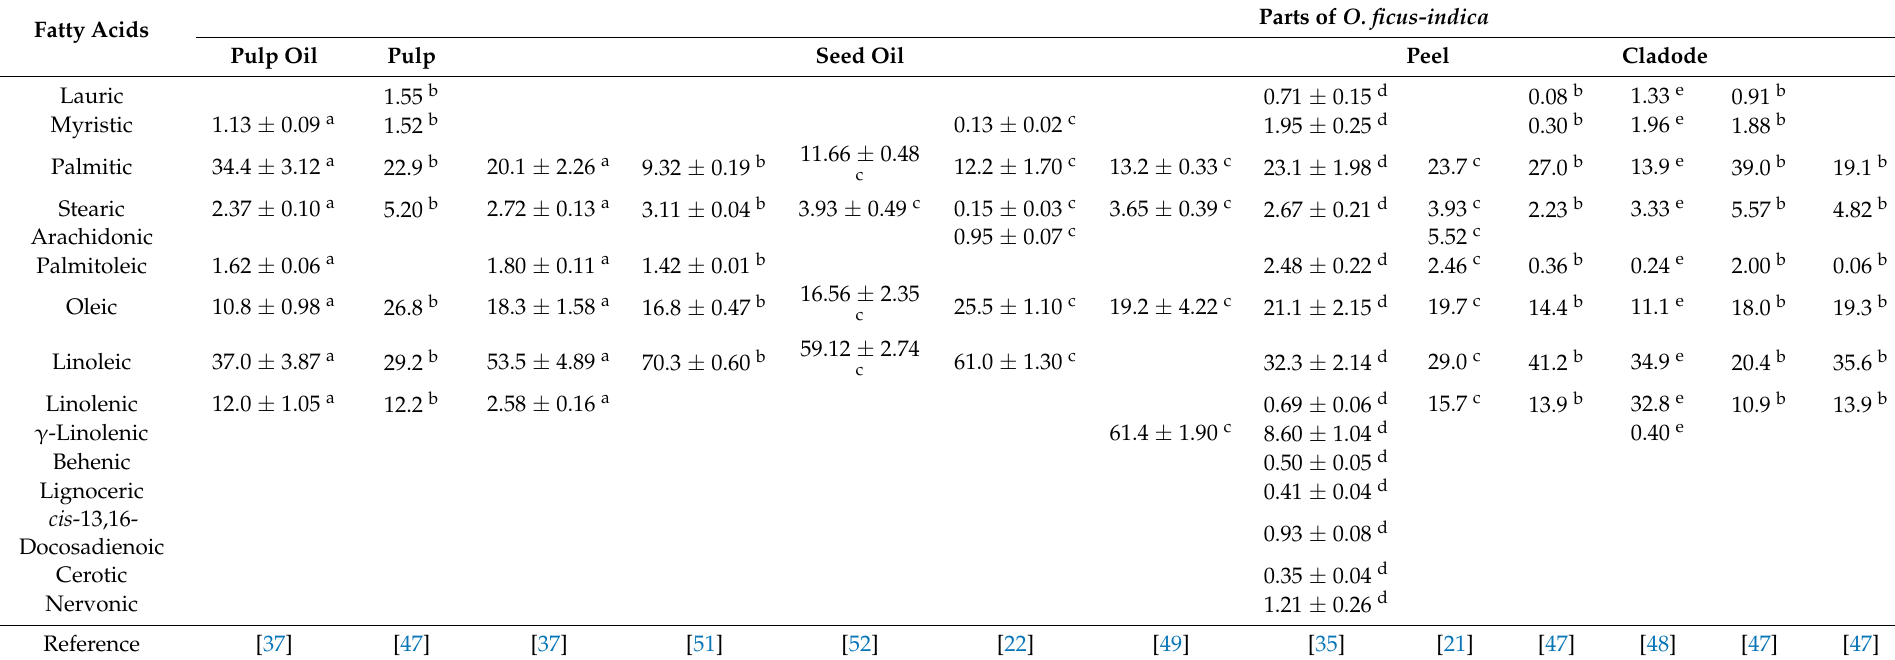
Table 4. Fatty acids content of the different parts of Opuntia ficus-indica (L.) Mill.